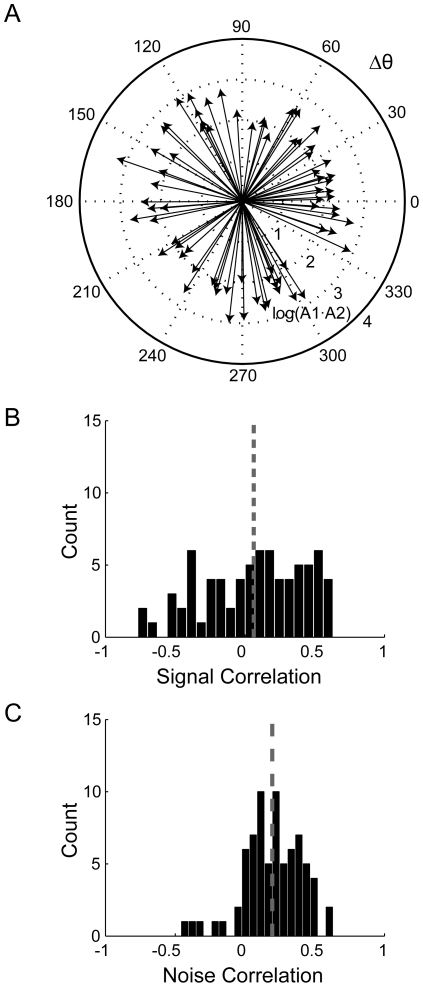
Interaction between pairs of pallidal neurons during movement.
A, Compass plot of interaction between responses to movement of all recorded pairs of neurons. Each arrow represents a pair of neurons: direction indicates the offset phase (Δθ) and length represents the multiplication of amplitudes of the sine fits (A1 and A2) on a logarithmic scale. B, Histogram of signal correlation. C, Histogram of noise correlation. Gray dashed lines in B and C indicate the mean value.